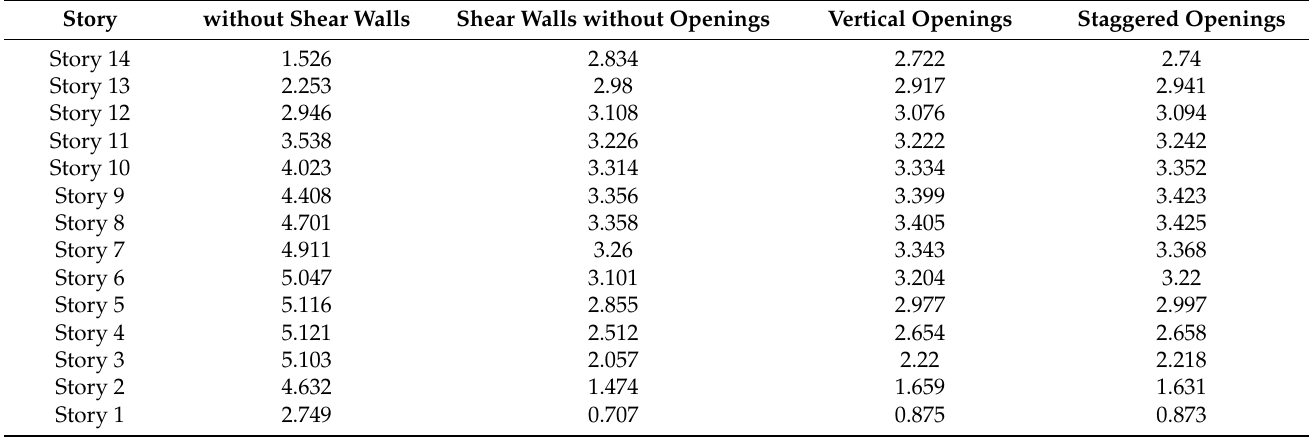
Table 11. Comparison of the story drift, static analysis, Y-direction (mm).